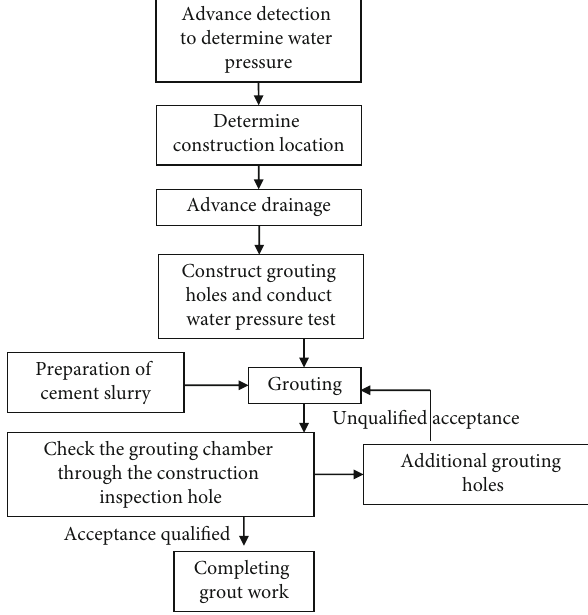
Figure 9: Curtain grouting process fl